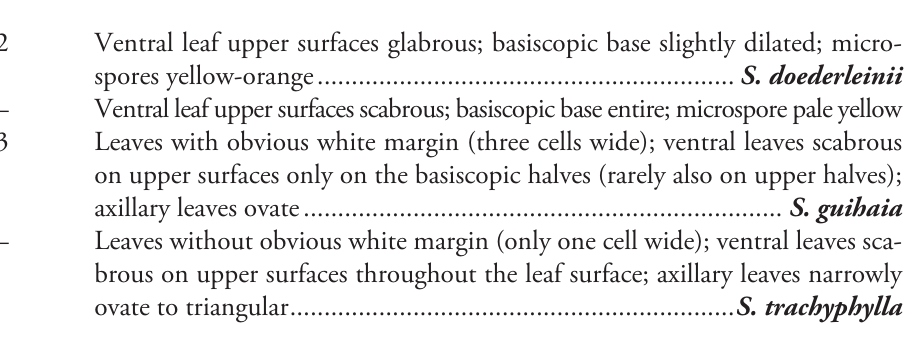
ovate to triangular ................................................................. S.